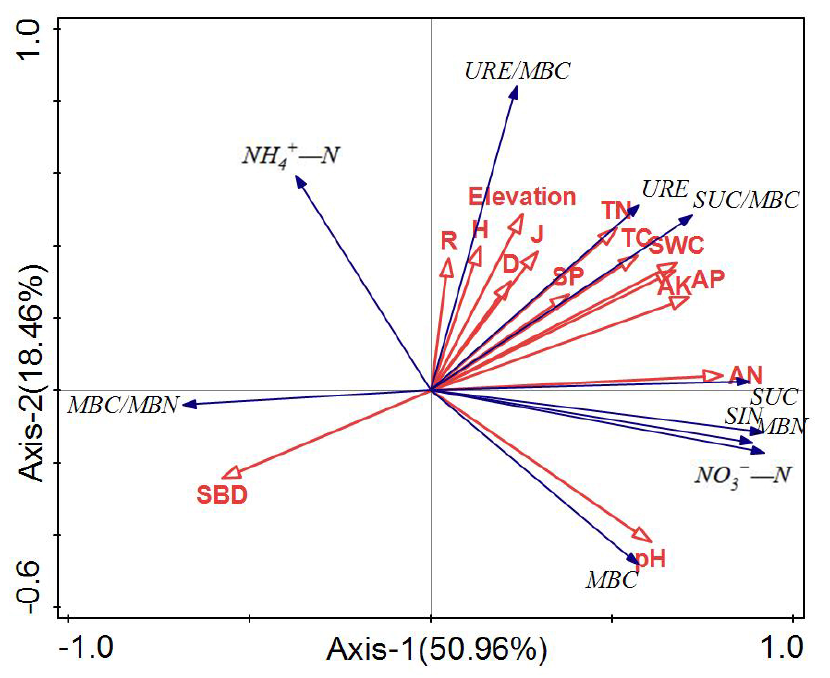
Figure 6. Redundancy analysis of the active soil substances along the elevation. H, Shannon–Wiener index; D, Simpson index; J, Pielou index; R, Margalef index; SP, soil porosity; SBD, soil bulk density; SWC, soil water contents; AN, available N; AP, available P; AK, available K. Table 5. Explanation of the impact factors in the redundancy analysis.